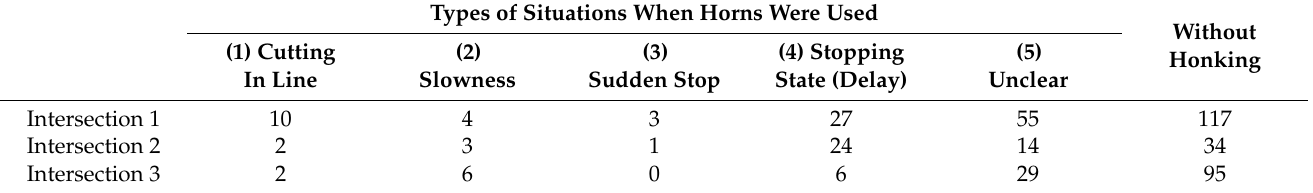
Table 8. The number of each situation with and without horn use in green light phases when left turns were possible.